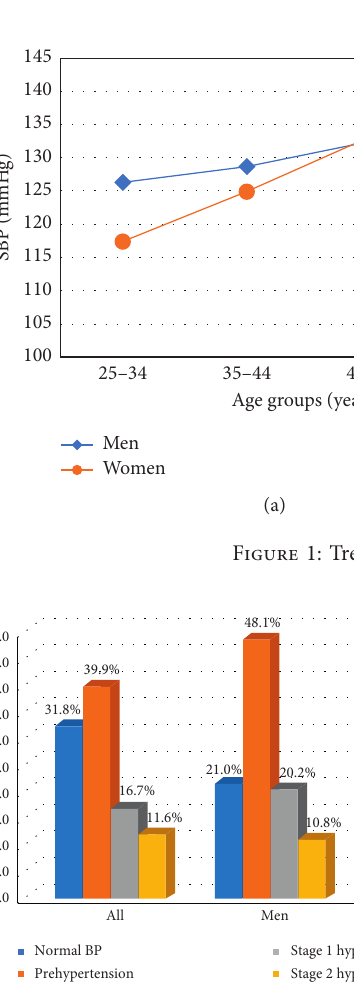
Figure 2: Distribution of blood pressure by